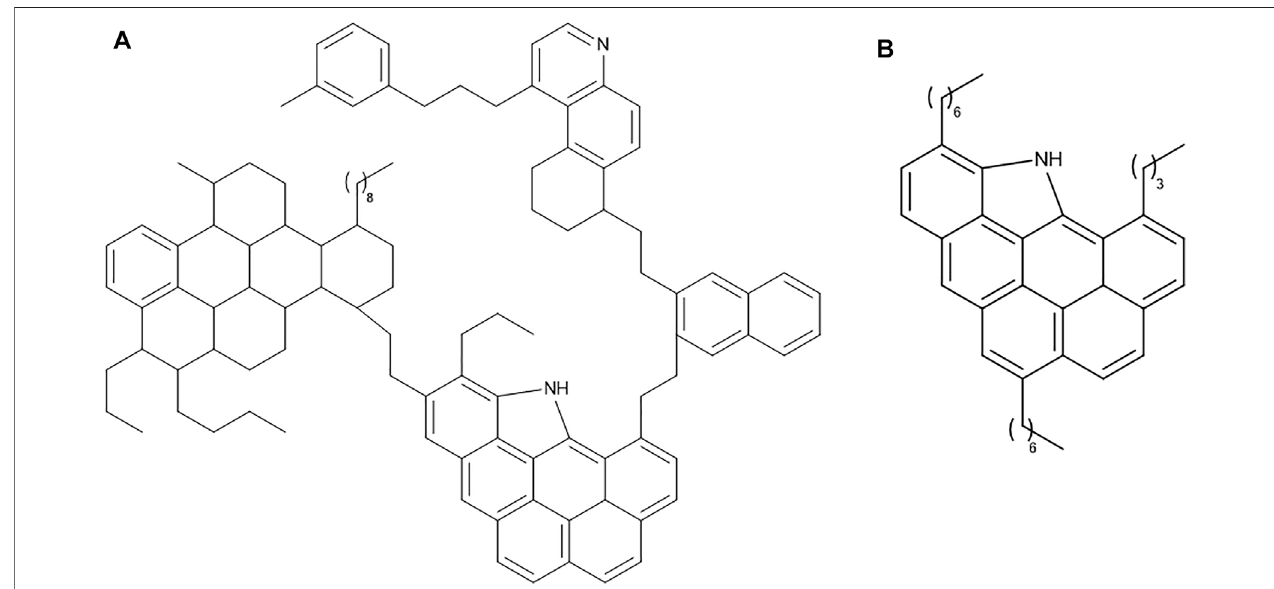
FIGURE 3 | Proposed structures of asphaltenes, adapted from (A) Groenzin and Mullins (2000); (B) Kuznicki et al. (2008).